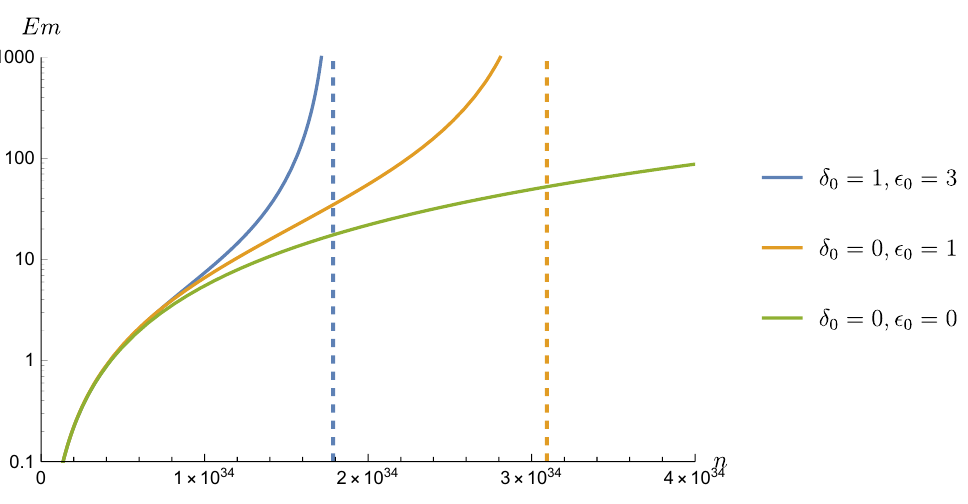
Figure 1. Energy, multiplied by mass, of a particle in a box of width L = 1 m. The green solid line corresponds to the standard case, while the blue and orange solid lines correspond to two different parametrizations for the model in Equation (20). The dashed vertical lines correspond to the maximum integer n allowed by the particular parametrization